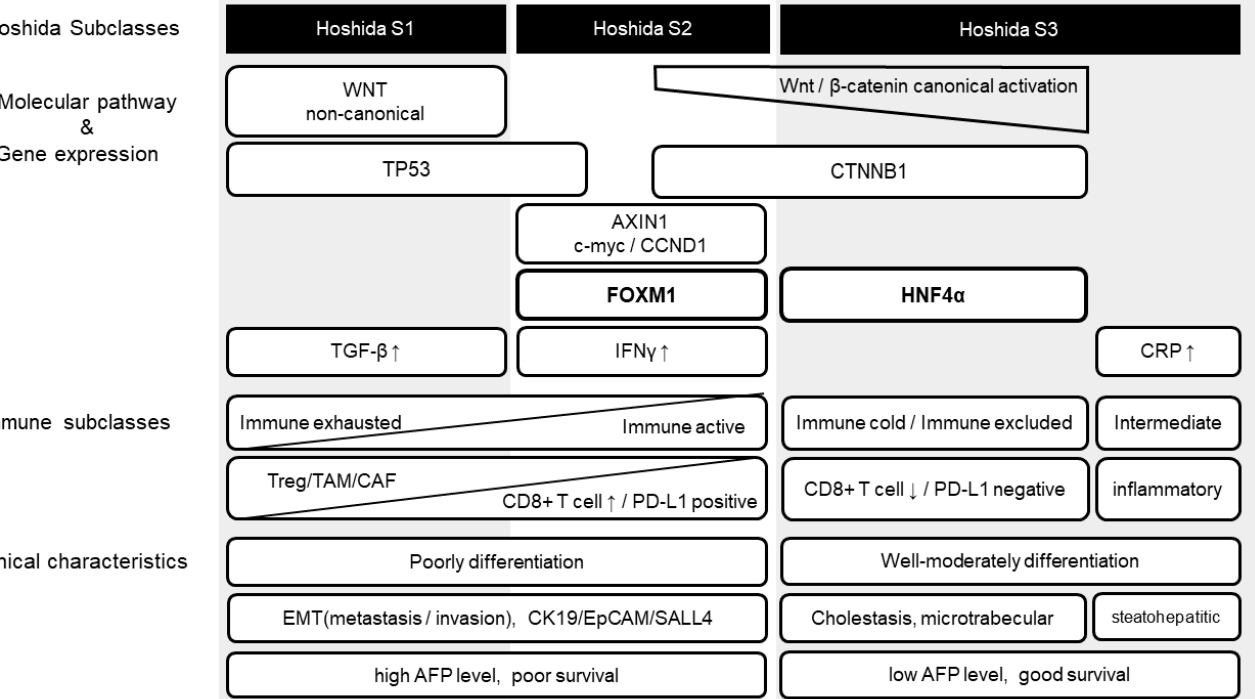
Figure 5. Comparison with previous subclasses. Hoshida subclass 1 is characterized by an enhanced noncanonical WNT/TGF- β axis, resulting in immune hot tumors enriched in tumor-infiltrating T lymphocytes, but also causing T-cell exhaustion in some cases. Hoshida subclass 2 HCCs present c-myc and CCND1 mutations, high serum AFP levels, stem cell features, and enhanced EMT. FOXM1 expression is upregulated in this subclass, and we believe that some of the canonical Wnt/ β -catenin activated HCCs may be herein included. This is probably an immune active and exhausted subclass. A part of Hoshida subclass 3 HCCs presents a good prognosis with CTNNB1 mutation (activated canonical Wnt/ β -catenin pathway), low serum AFP levels, and are well-to-moderately differentiated and non-aggressive. Being an immune cold tumor with fewer tumor-infiltrating T- lymphocytes, it may be difficult to treat, even with immune checkpoint inhibitors.